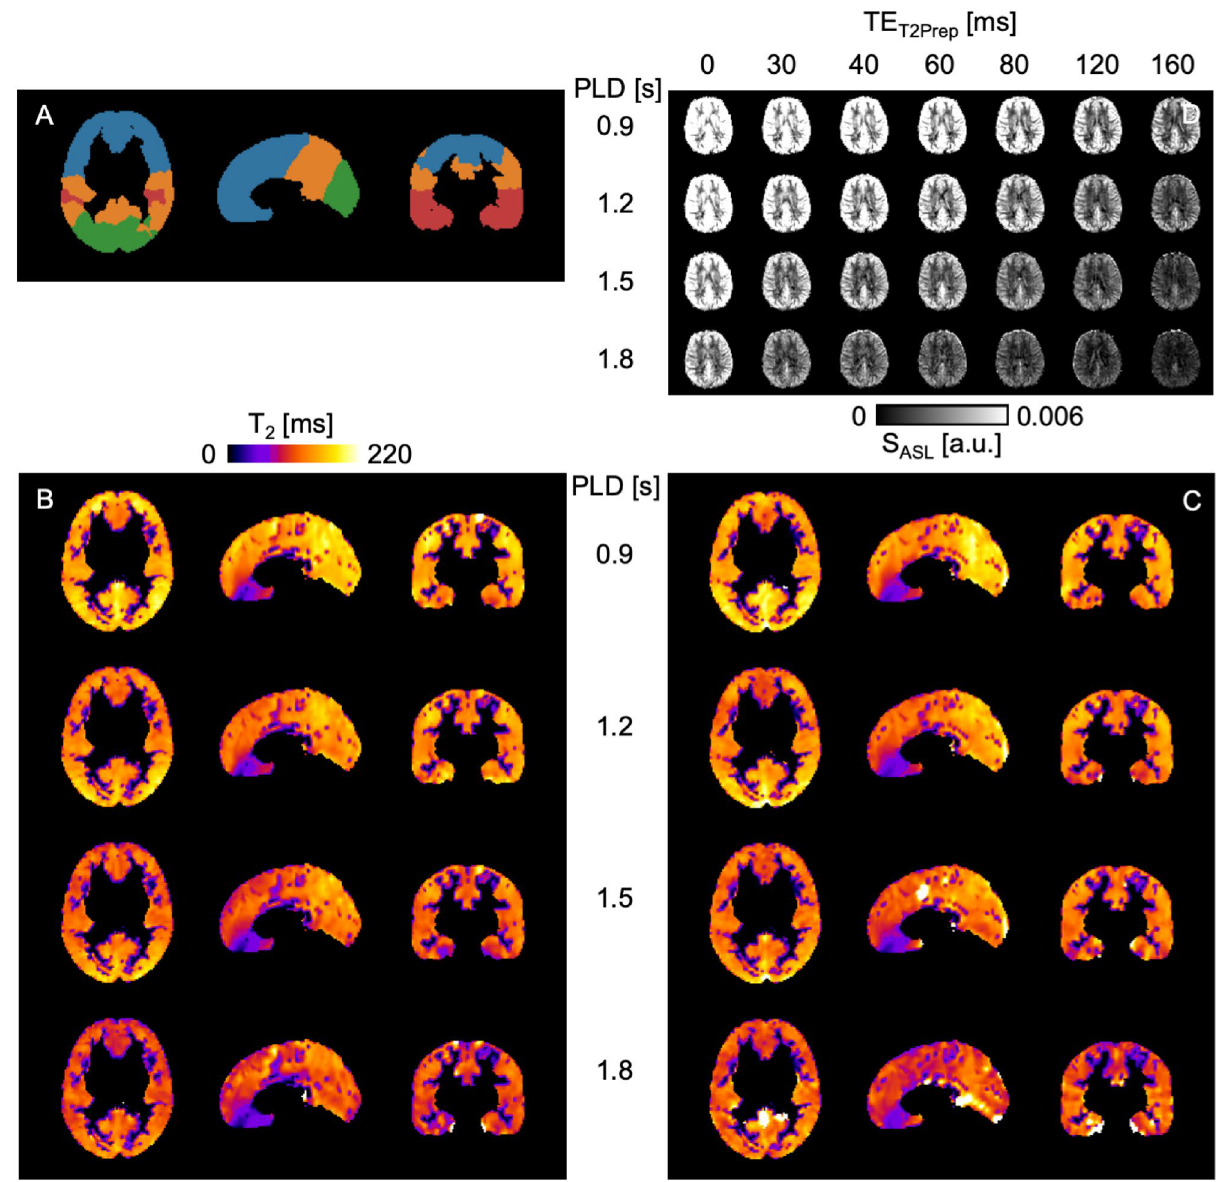
Figure 2. ( A ) Regions of interest (ROIs) of the MNI reference map: frontal (blue), occipital (green), parietal (orange), temporal (red) and corresponding masked gray matter T 2 maps in MNI space for all postlabeling delays PLD = 0.9/1.2/1.5/1.8 s for ( B ) test and ( C ) retest scans of one single subject. ( D ) Mean perfusion- weighted, non-smoothed whole brain ASL signal maps in native space for all PLDs and T 2 preparation times TE T2Prep = 0/30/40/60/80/120/160